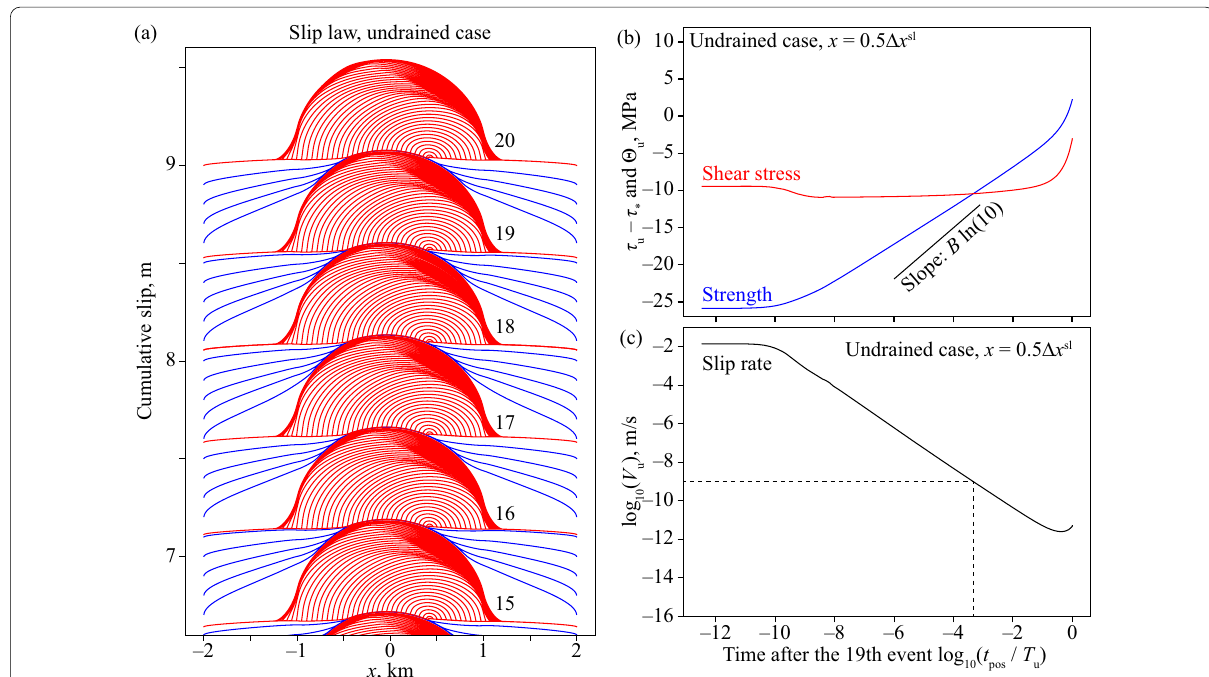
Fig. 8 Simulation result in the undrained case with the slip law. For presentational purposes, the length scale is selected as R = 1km . a Cumulative slip distribution, blue: every 10 8 s , red: every 0.02s during earthquakes. Integers indicate ordinal numbers of earthquakes in the simulated sequence. b Shear stress (red) and strength (bule) of the fault relative to the reference at x = 0.5 � x sl = R / 2048 as a function of time after the 19th earthquake. c Slip rate near the center, x = 0.5 (cid:31) x sl as a function of time after the 19th